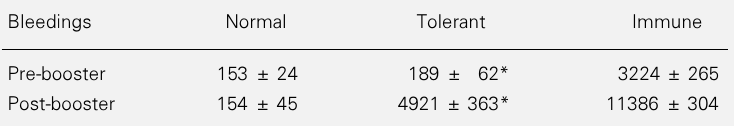
Figure 1 - Immune responses of normal and orally tolerant B6D2F1 mice of different ages. Mice were fed by gavage with either saline or 20 mg ovalbumin (Ova) 7 days be- fore primary ip immunization with 10 (cid:181)g Ova + 1 mg Al(OH) 3 . All ani- mals were boosted ip with 10 (cid:181)g Ova 14 days later and sera were collected 7 days after the booster. Anti-Ova antibodies were meas- ured by ELISA and the numbers represent the running sum of ab- sorbance ranging from 1/100 to 1/ 3200 in one group (N = 6-8). Signifi- cant differences between Ova-fed and saline-fed groups were calcu- lated by the two-tailed Student t - test. A significant difference (P<0.001) between groups was ob- served only in 8-week-old mice.